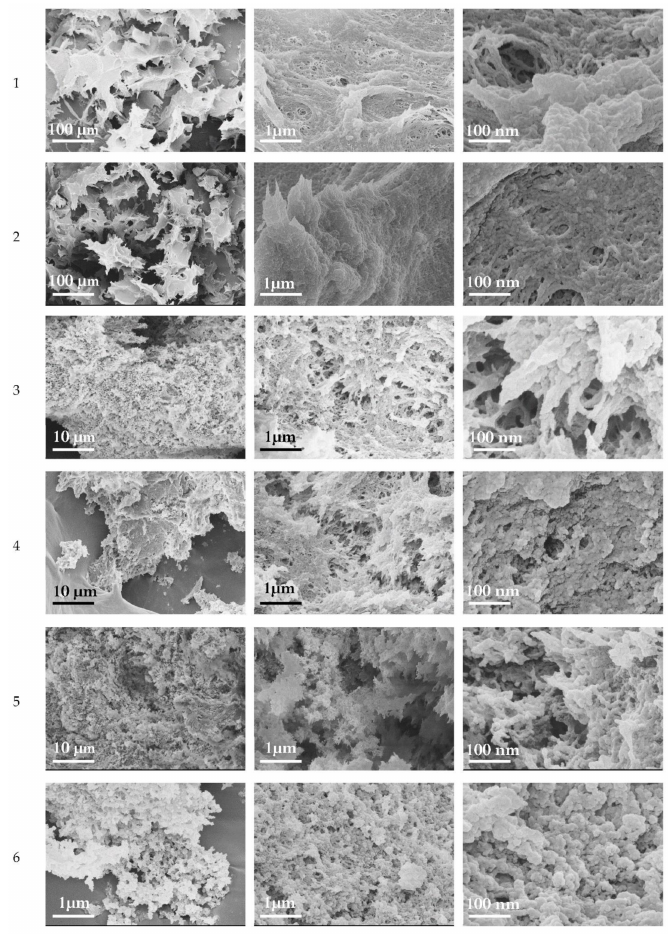
Figure 3. SEM images of cryogel samples